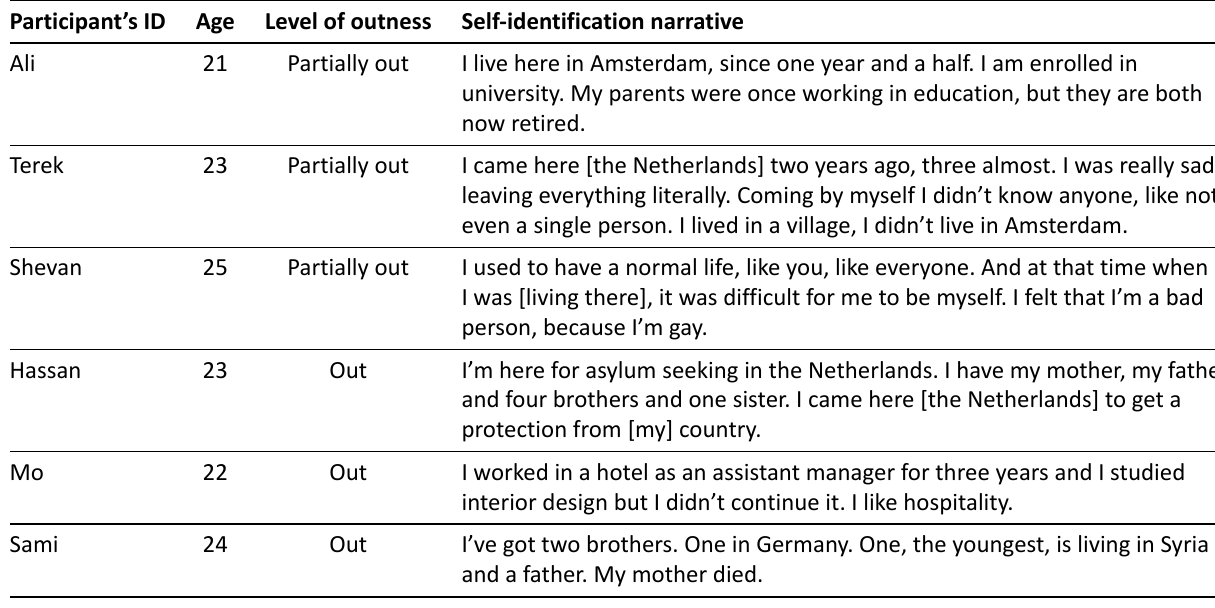
Table 1. Forced migrant demographics and their personal self-identification narratives. Participant’s